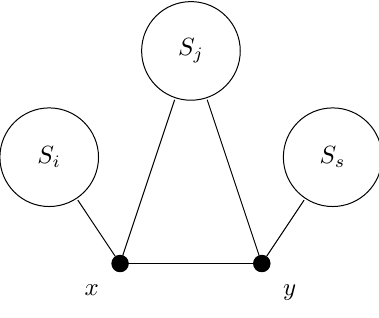
Fig. 2: “Triangle Free” forbids the assignment of x to S i , y to S